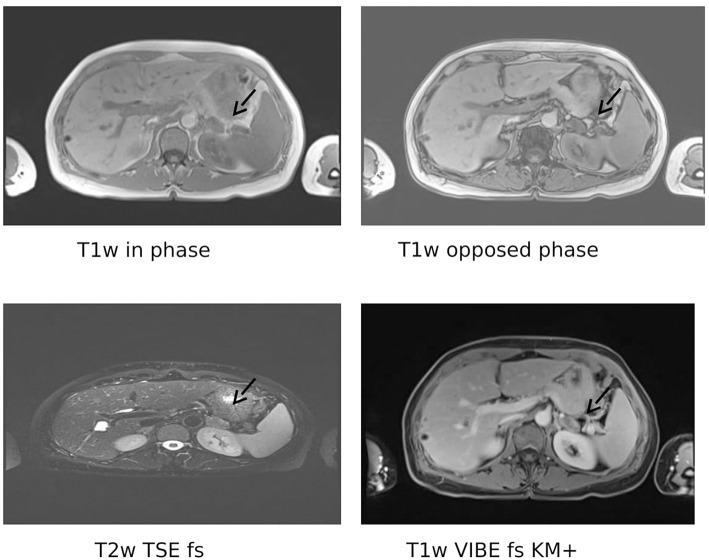
Magnetic resonance imaging. Shown is a left-sided adrenal mass (arrows) with a maximum diameter of 2.3 cm. Only slight signal loss in the opposed phase on Tl weighted-images. Mild contrast-enhancement in the periphery of the tumor. Multiple hepatic cysts. Tlw, T2w: Tl- or T2 weighted, respectively; TSE, turbo spin echo; VIBE, volumetric interpolated breath-hold examination; FS, fat saturated; KM+, with contrast agent.